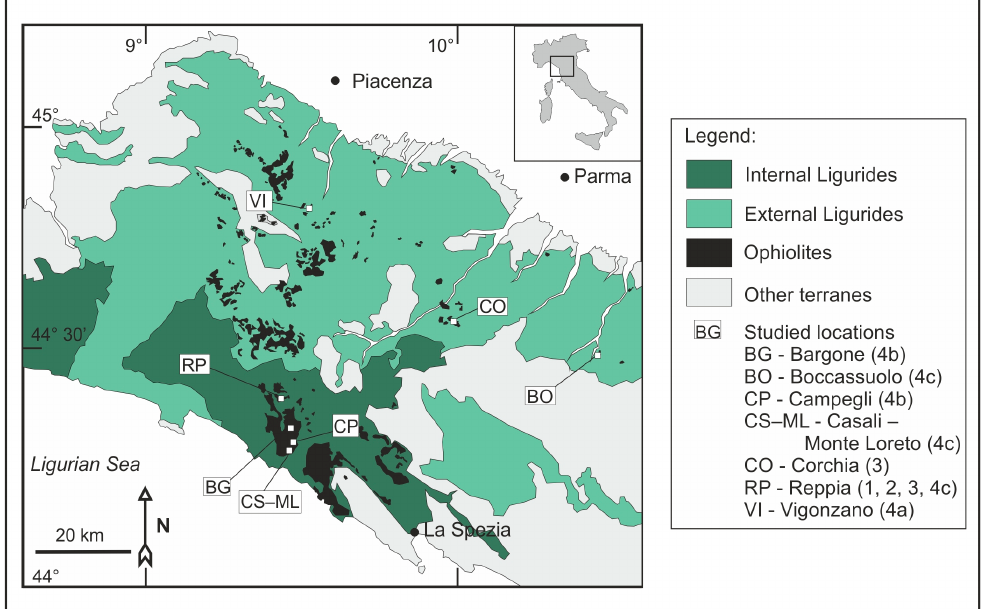
Figure 1. Simplified geological map (based on [15]) showing the ophiolites of the Northern Apennines and the study locations. Numbers refer to the deposit types introduced in Section 2.